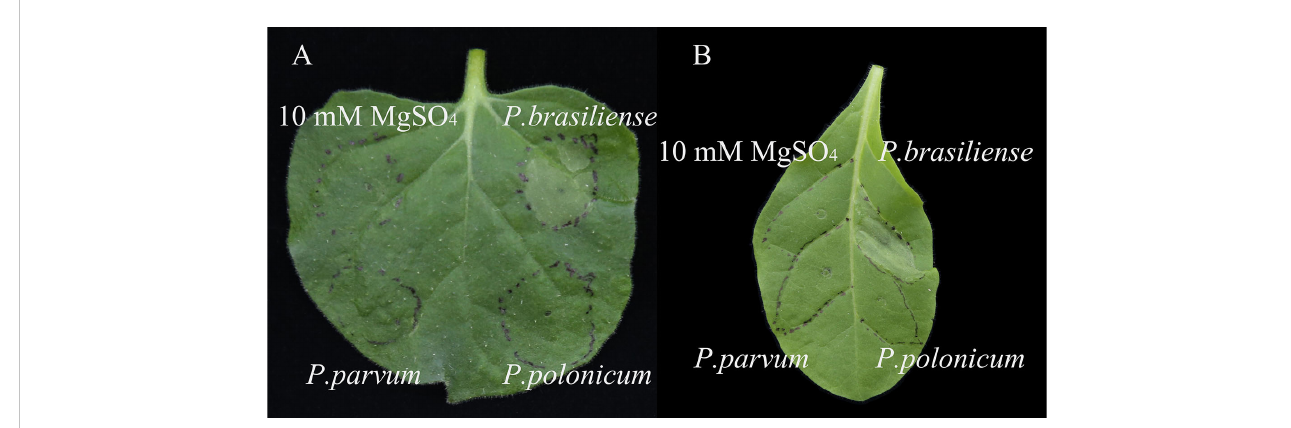
FIGURE 4 Hypersensitive response in (A) Nicotiana benthamiana and (B) N. tabacum leaves in fi ltrated with the Pectobacterium species. P. brasiliense isolate